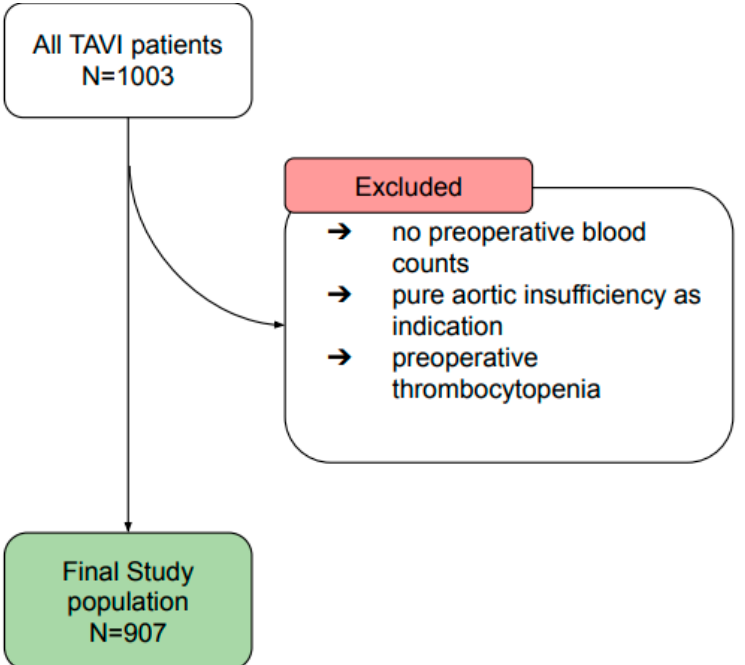
Figure 1. A flowchart showing the selection process of the study population. In total, the data from 907 patients were retrospectively evaluated. All procedures were conducted in a hybrid operating room under fluoroscopic control (Artis Zeego Sys- tem, Siemens AG, Erlangen, Germany), general anesthesia, periprocedural TEE, and a cardiac perfusionist with a ready-to-use cardiopulmonary bypass on site. All implantations were performed by a team composed of an interventional cardiologist and a cardiac sur- geon. Patients received either a balloon-expanding (Sapien, SapienXT, Sapien3, Edwards Lifesciences Inc., Irvine, CA, USA) or a self-expanding valve prosthesis (e.g., Medtronic CoreValve, CoreValve Evolut R, CoreValve EvolutPro, Engager, Medtronic, Minneapo- lis, MN: Acurate, Acurate neo, Symetis SA, Ecublens, Switzerland). The selection of the prosthesis was individually made for each patient by the heart team, based on echocardiog- raphy and CT findings. Per institutional protocol, the transfemoral approach (TF-TAVI) was the preferred standard access. In case of severe peripheral arteriopathy, transapical access was performed (TA-TAVI). After the procedure, all patients were loaded with 300 mg clopidogrel, and starting from day 1, received a double antiaggregation therapy consisting of 100 mg/die acetylsalicylic acid, and 75 mg/die clopidogrel for three months. Moreover, low-molecular-weight heparin was applied during the hospital stay, as prophylaxis for deep vein thrombosis. All patients provided written informed consent for the anonymous use of their data, and the study was approved by our institutional study center (SZ_D_125.20-I-6). The study protocol conforms to the ethical guidelines in the Declaration of